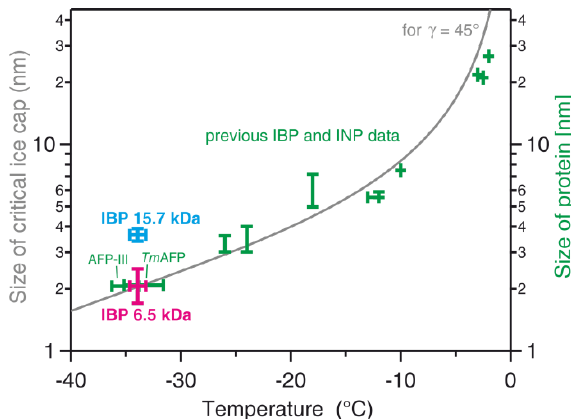
Figure 10. Heterogeneous ice nucleation temperatures for various biological molecular ice nucleators in relation to their size. Magenta = range of median freezing temperatures (adjusted for the effect of the buffer) for Collembolan ice-binding protein (IBP at 6.5 kDa) solutions of different concentrations as determined in the current study. Green = data for IBPs and ice-nucleating proteins (INPs) from previous publications; two recently investigated IBPs from a fish (AFP-III) and an insect ( Tm AFP) are indicated (see [13] for the data sources). The cyan data point indicates the size of the 15.7 kDa IBP protein at the observed ice nucleation temperature (note that we consider it unlikely that the freezing was indeed due to this 15.7 kDa IBP, see the end of the discussion section in the main text). The grey line corresponds to the size (diameter) of the critical spherical ice cap formed on the protein surface with a contact angle γ of 45° of ice to the protein surface as predicted from CNT calculations (see the text above and Section 3.4 for details).